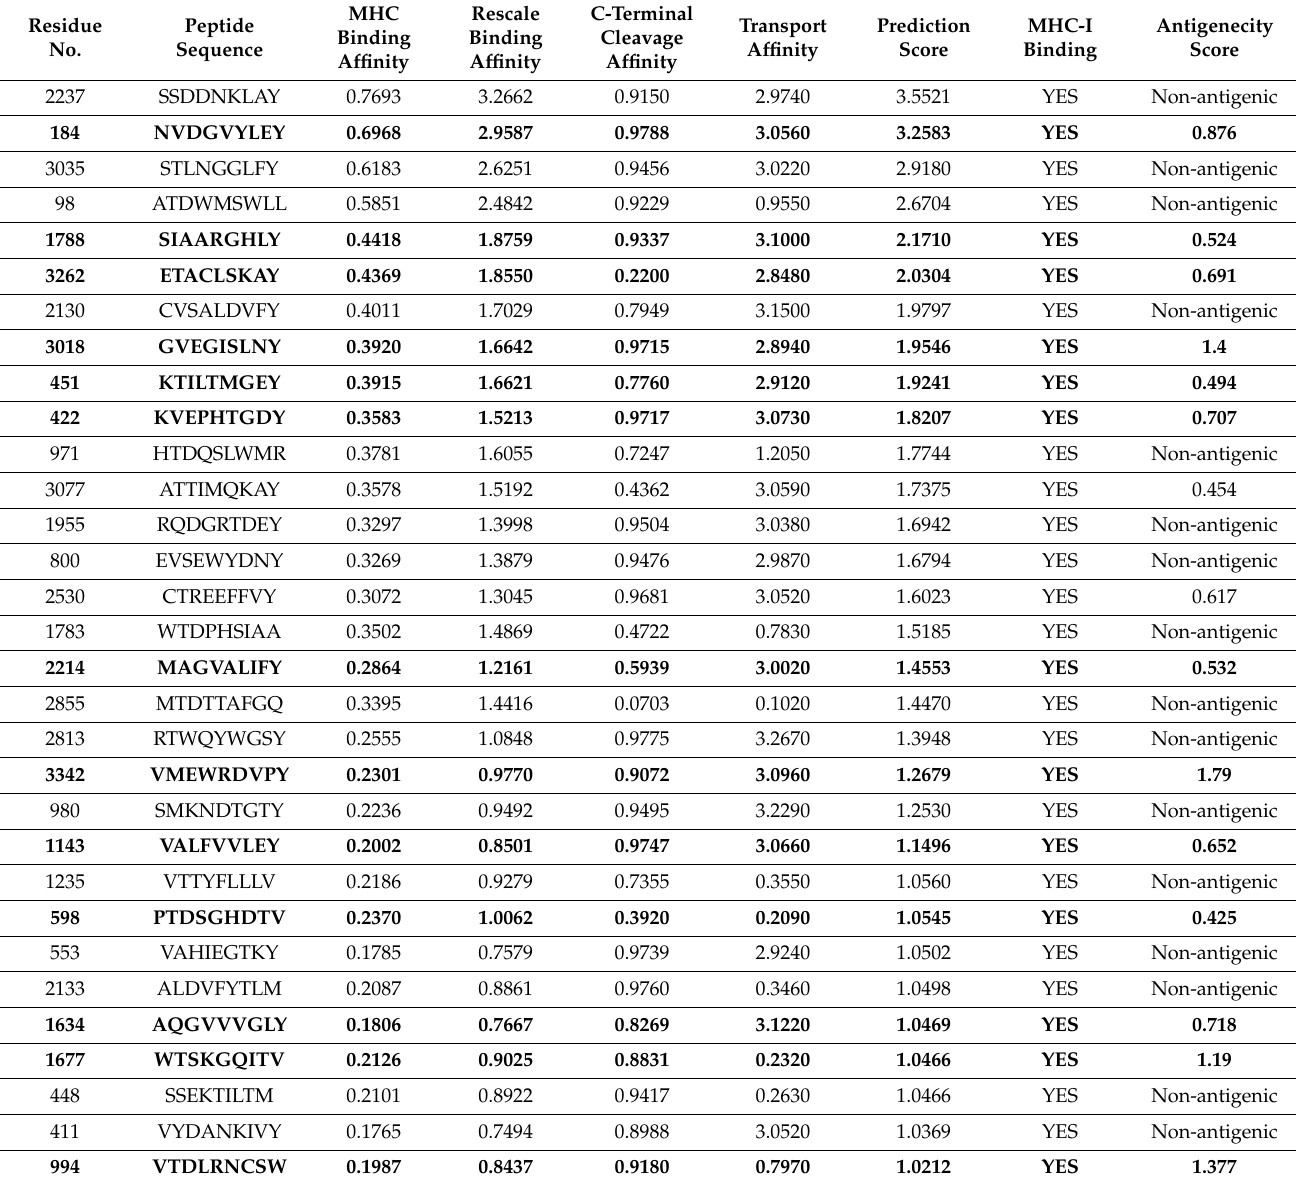
Table 1. Predicted CTL epitopes. The selection of appropriate candidates was based on C-terminal cleavage, TAP scores, and antigenicity. The CTL epitopes shown in bold are the finally selected epitopes for multi-epitopes vaccine construct. Residue